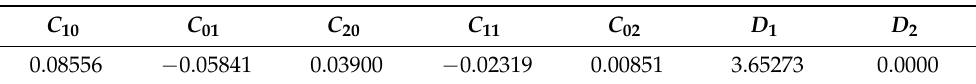
Table 2. The coefficient of the hyperelastic material model used for the encapsulated soft